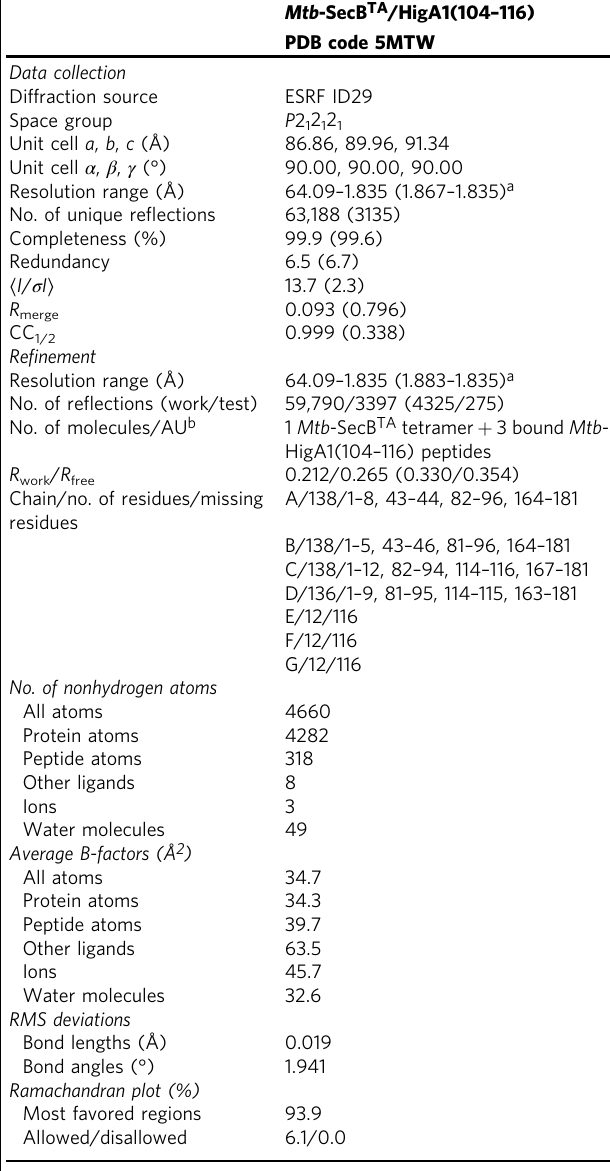
Table 1 Crystallographic data collection and re fi